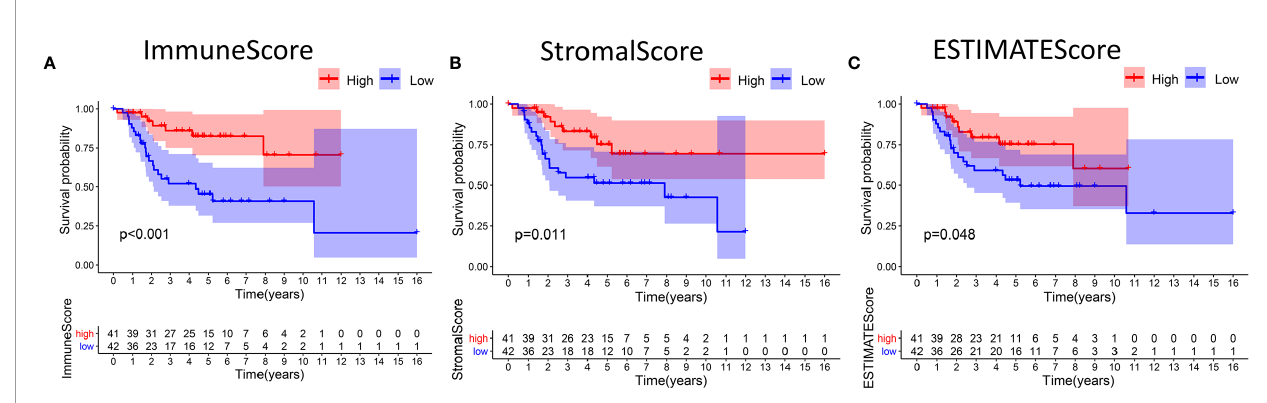
FIGURE 1 | Associations between the scores and survival of OS patients. (A) Kaplan-Meier survival analysis of OS patients in the high and low ImmuneScore subgroups, log-rank test p < 0.001. (B) Survival analysis of patients in the high and low StromalScore groups, p =0.011. (C) Survival analysis of OS patients in the high and low ESTIMATEScore groups, p